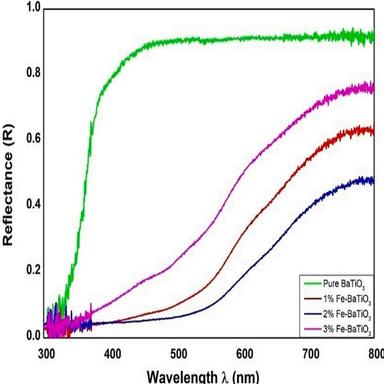
Reflectance v/s wavelength graph of prepared samples.